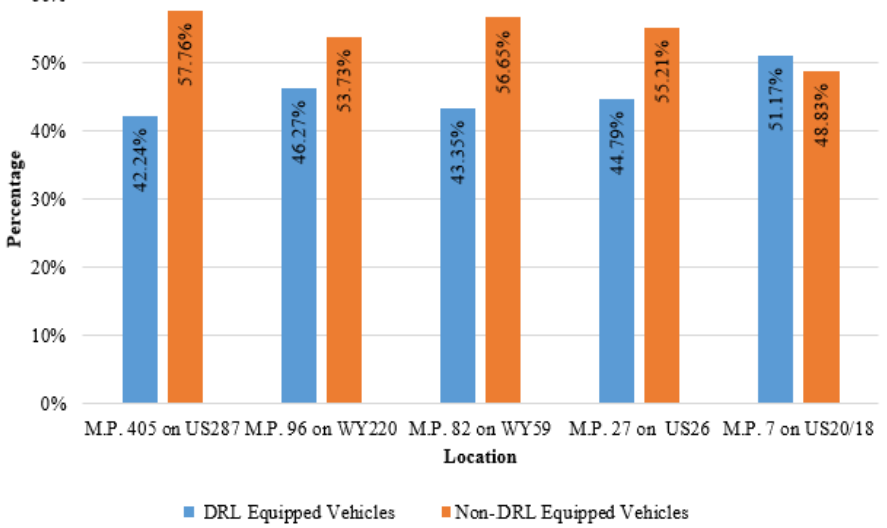
Figure 4: Percentage of Vehicles Equipped with DRL Vs Vehicles Non-DRL